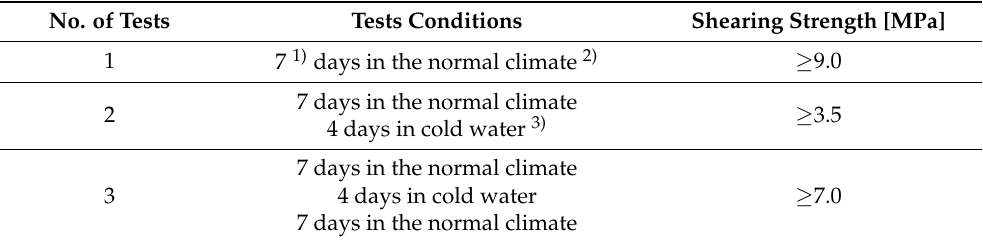
Table 2. Strength and resistance tests of adhesive joints according to the ITB technical approvals AT-15-2948/00 [45].